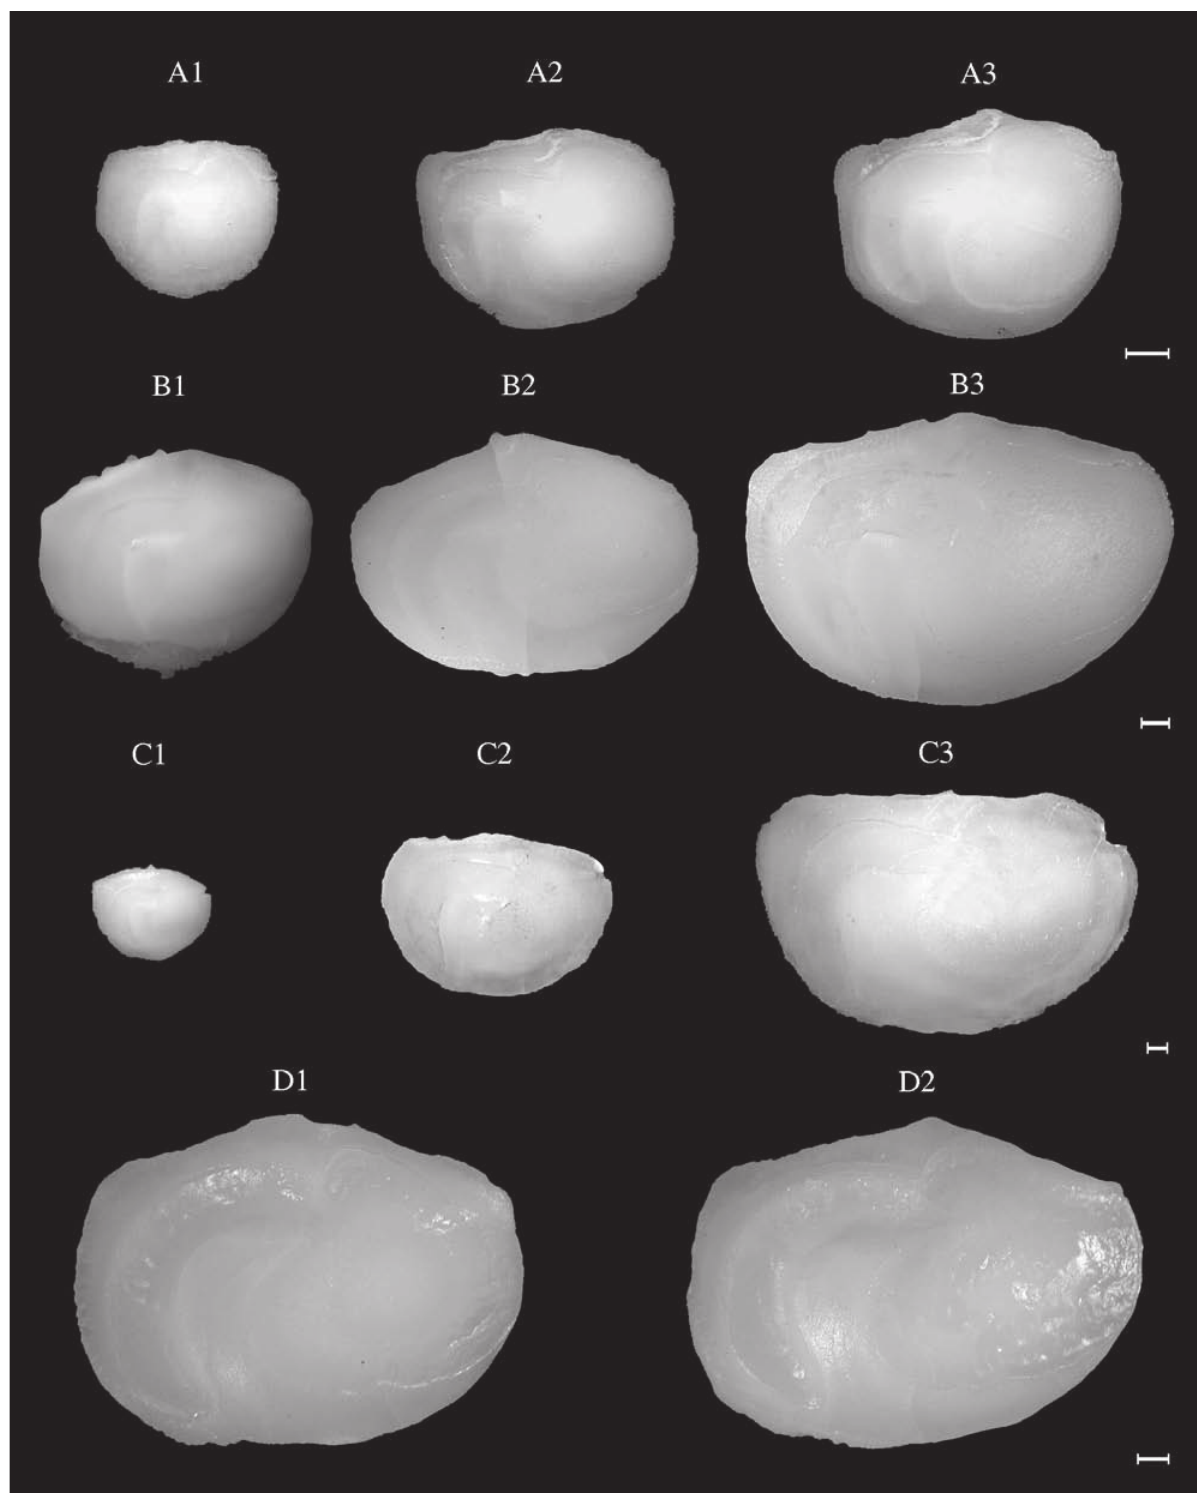
Fig. 65. – Sciaena umbra (WM) . TL: A1, 25.0 cm; A2, 35.0 cm; A3, 49.9 cm. Umbrina canariensis. TL: B1, 23.5 cm (WM); B2, 30.2 cm (CEA); B3, 40.0 cm (CEA). Umbrina cirrosa (WM) . TL: C1, 11.5 cm; C2, 32.5 cm; C3, 54.0 cm. Umbrina ronchus (CEA) . TL: D1, 33.4 cm; D2, 36.6 cm. Scale bar = 1